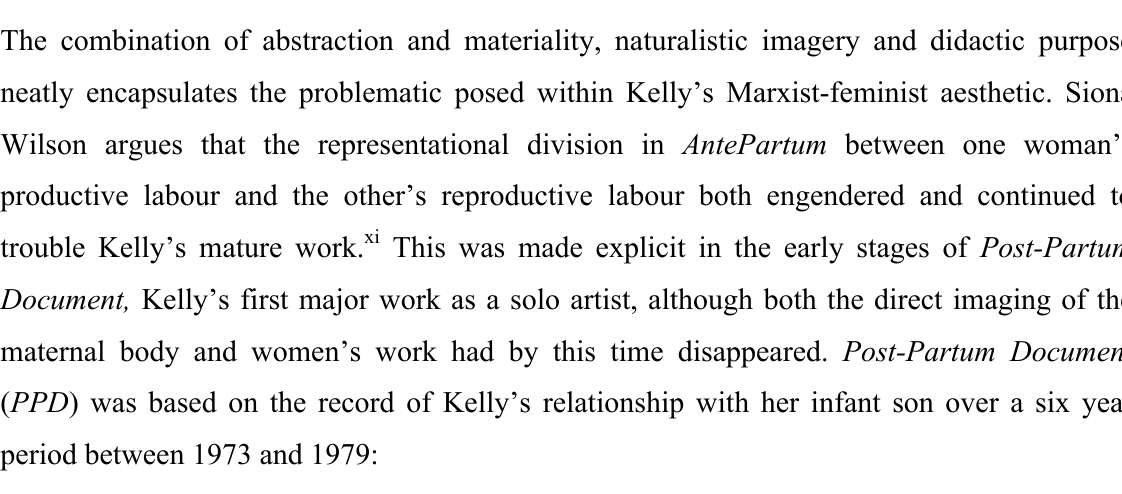
Figure 5: Mary Kelly Antepartum 1973, 8mm film transferred to DVD